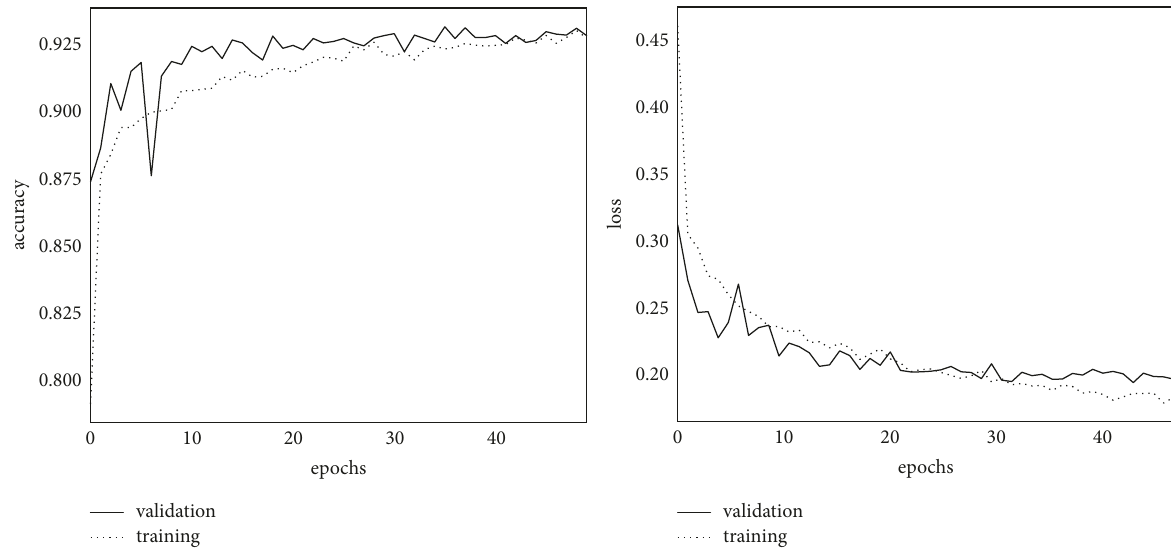
Figure 3: Accuracy and loss function during training and validation shown for 50 epochs. The values for the training dataset are computed with 50% dropout rate to provide a more robust estimate.